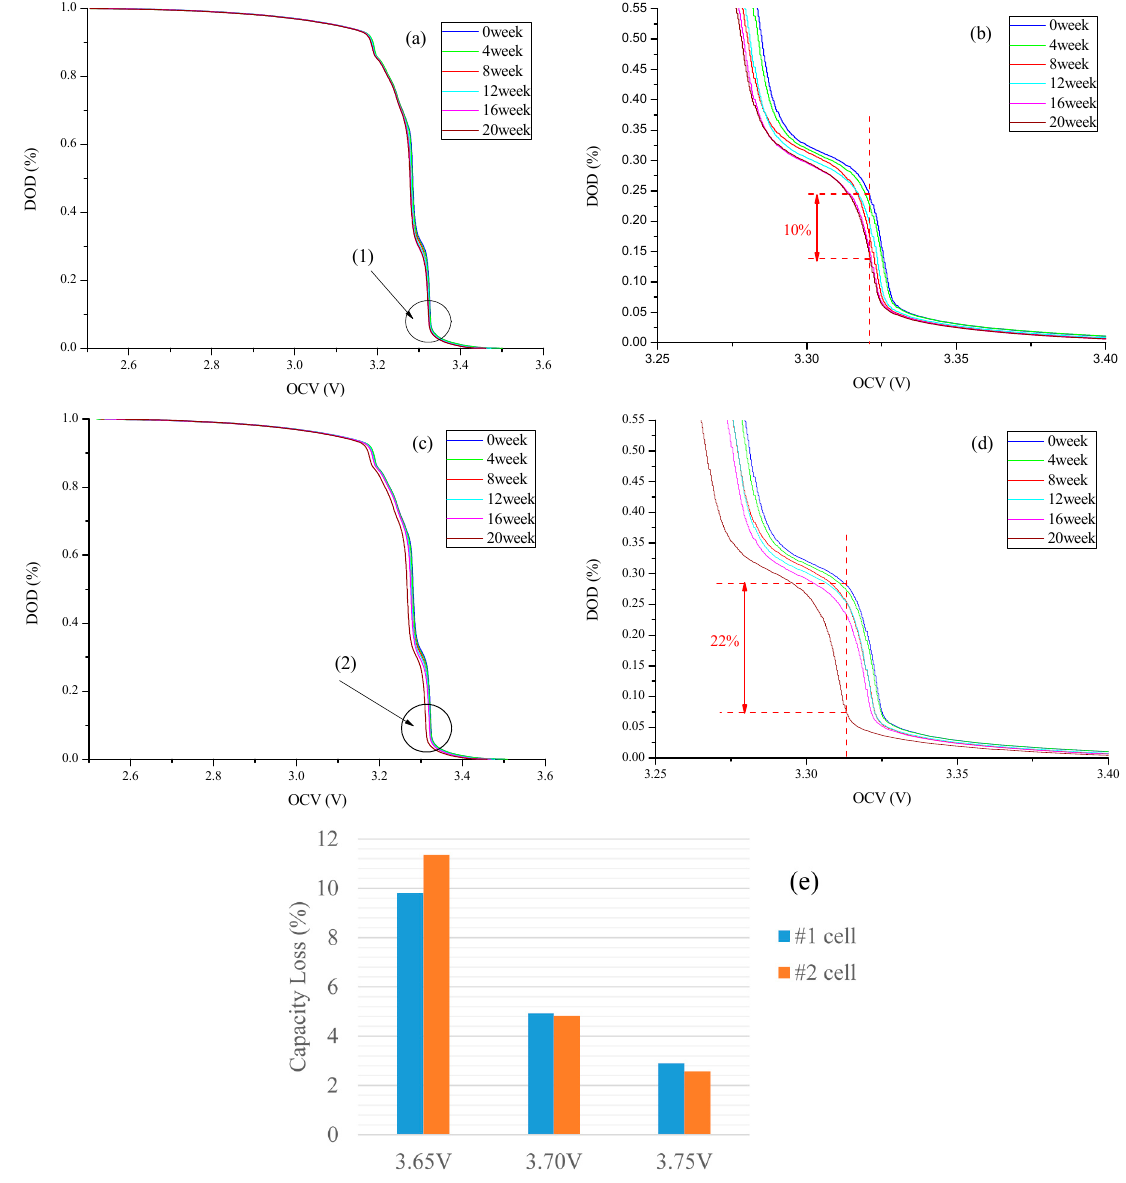
Figure 8. ( a – d ) DOD vs. cell voltage curve and the enlarged view of (1) and (2) place; and ( e ) capacity loss of cells #1 and #2 at different cut-off voltage determined by C/3C.